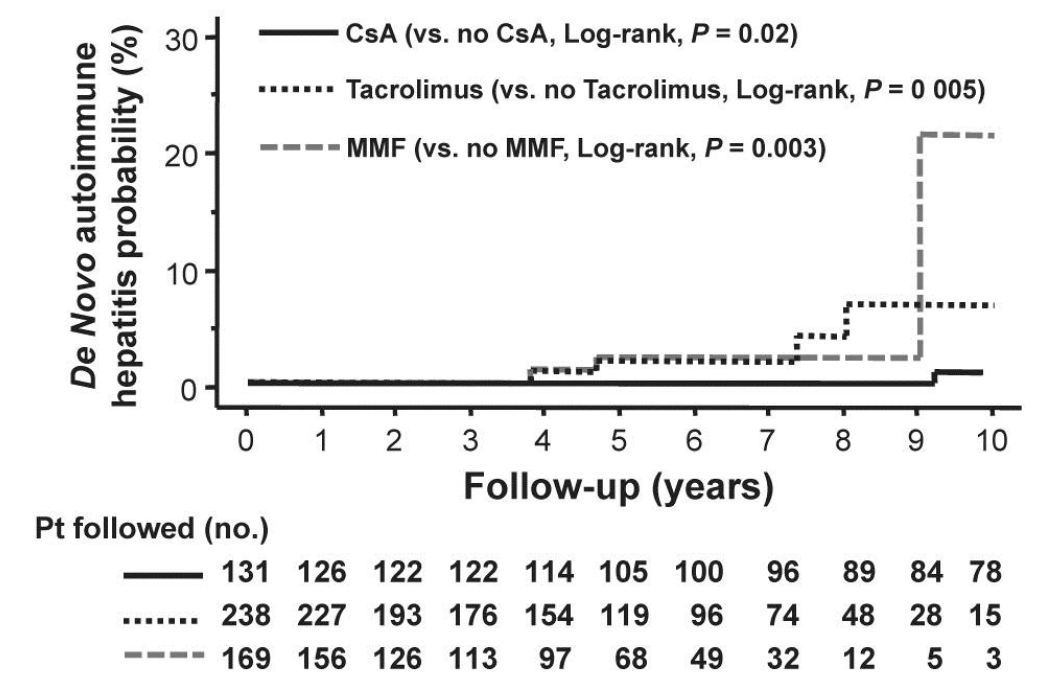
Figure 2. Cumulative probability of de novo autoimmune hepatitis according to the use of cyclosporine A (—), tacrolimus ( ….. ) and mycophenolate mofetil (- - -). The 5- and 10-year probability of development of de novo autoimmune hepatitis with cyclosporine A was 0 and 1.2% respectively; the 5- and 10-year probability of development with tacrolimus was 1.9% and 6.0% respectively; and the 5- and 10-year probability of development with mycophenolate mofetil was 3.1 and 22.5% respectively. (With permission of John Wiley and Sons and Liver